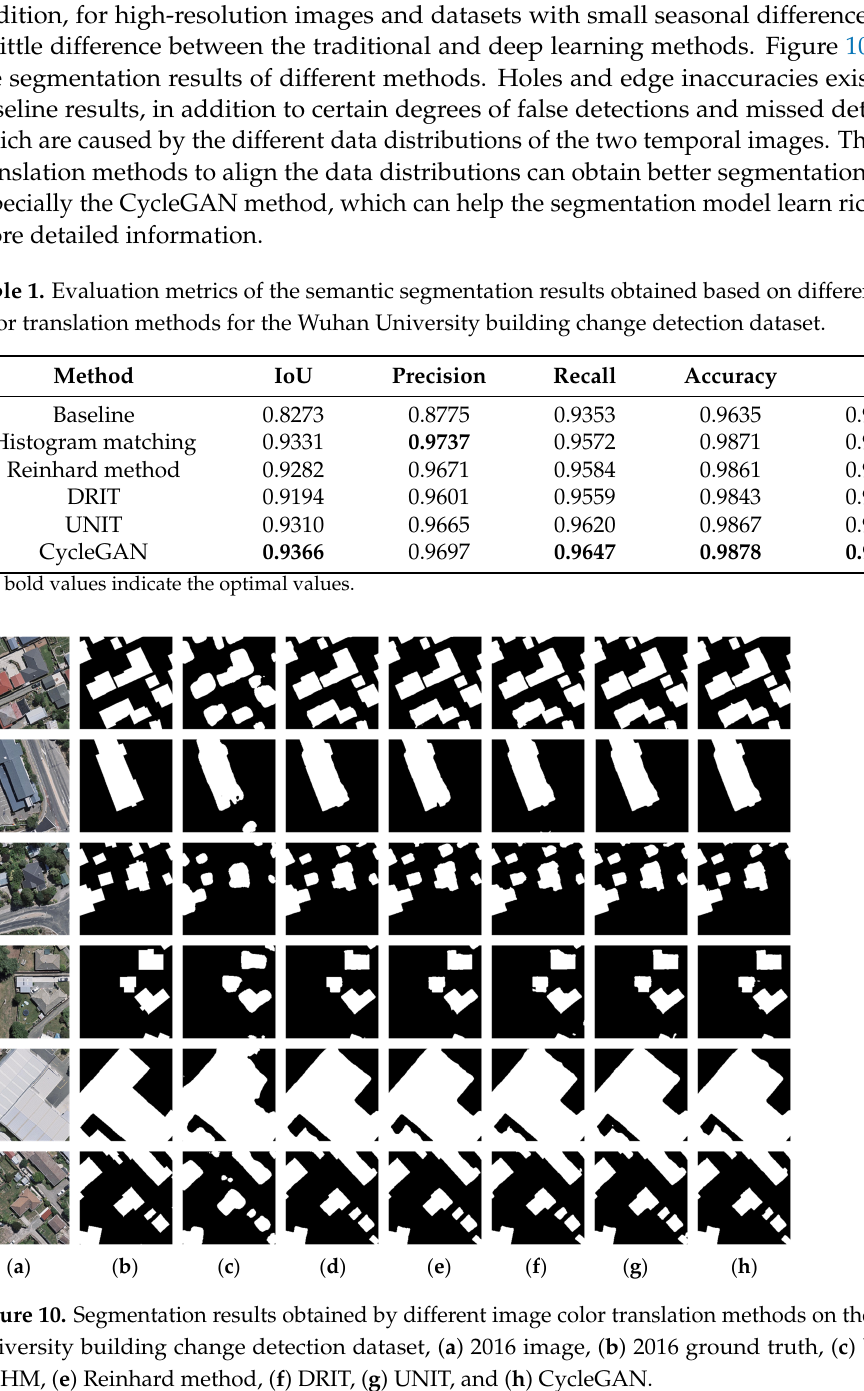
Table 1. Evaluation metrics of the semantic segmentation results obtained based on different image color translation methods for the Wuhan University building change detection dataset.